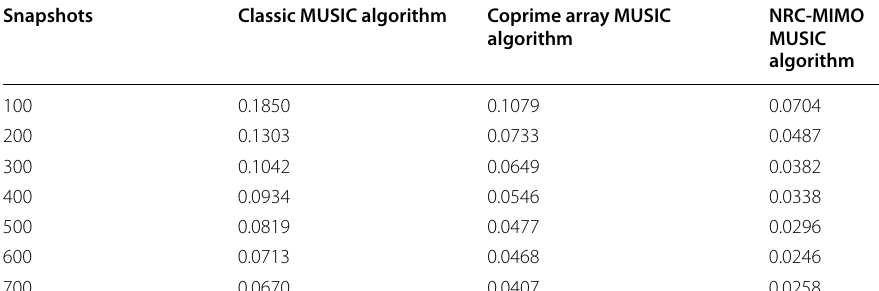
Table 4 RMSE values under different snapshots